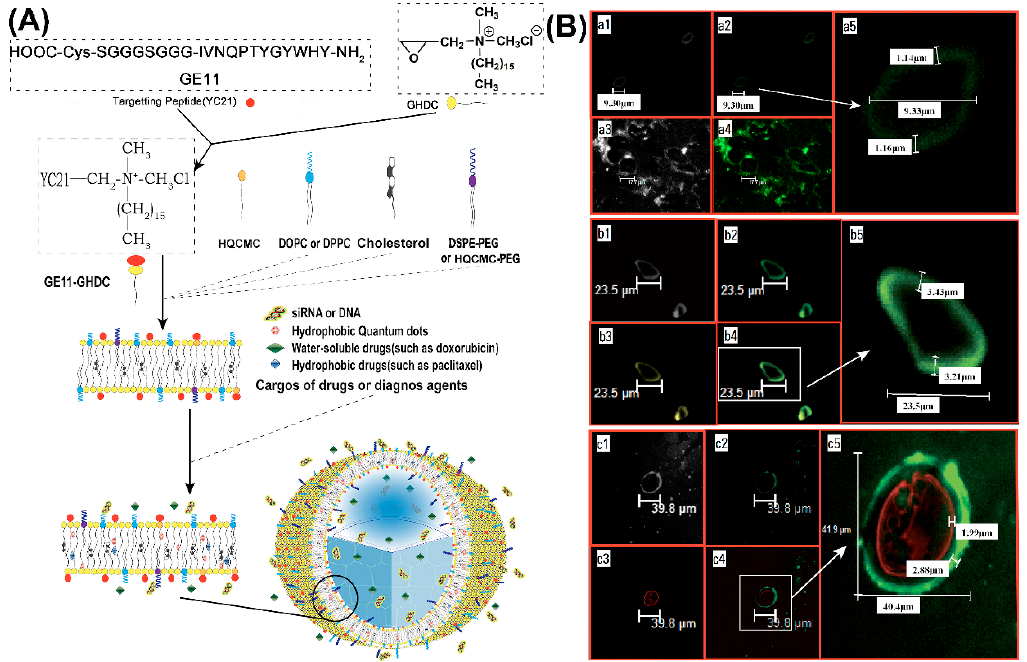
Figure 4. ( A ) Schematic of epidermal growth factor receptor (EGFR)-targeted self-assembled peptide vesicles (SPVs) formed from amphiphilic peptide surfactant and lipid components. ( B ) Physical and microstructural characteristics of EGFR-targeted SPVs. ( a ) Confocal images of large peptide microparticles, showing large unilamellar vesicles with an external peptide-lipid bilayer (approximately 1.15 μ m thick). ( b ) Confocal images of large peptide microparticles encapsulating hydrophobic QDs (yellow fluorescence), showing large unilamellar vesicles with an external peptide-lipid bilayer (approximately 3.21 µ m thick). ( c ) Confocal images of large peptide microparticles encapsulating a hydrophilic genetic payload (cy3-labelled siRNA with red fluorescence), showing large unilamellar vesicles with an external peptide-lipid bilayer (approximately 2.88 µ m thick). Reproduced from [67], with permission. Copyright: 2016 Elsevier.